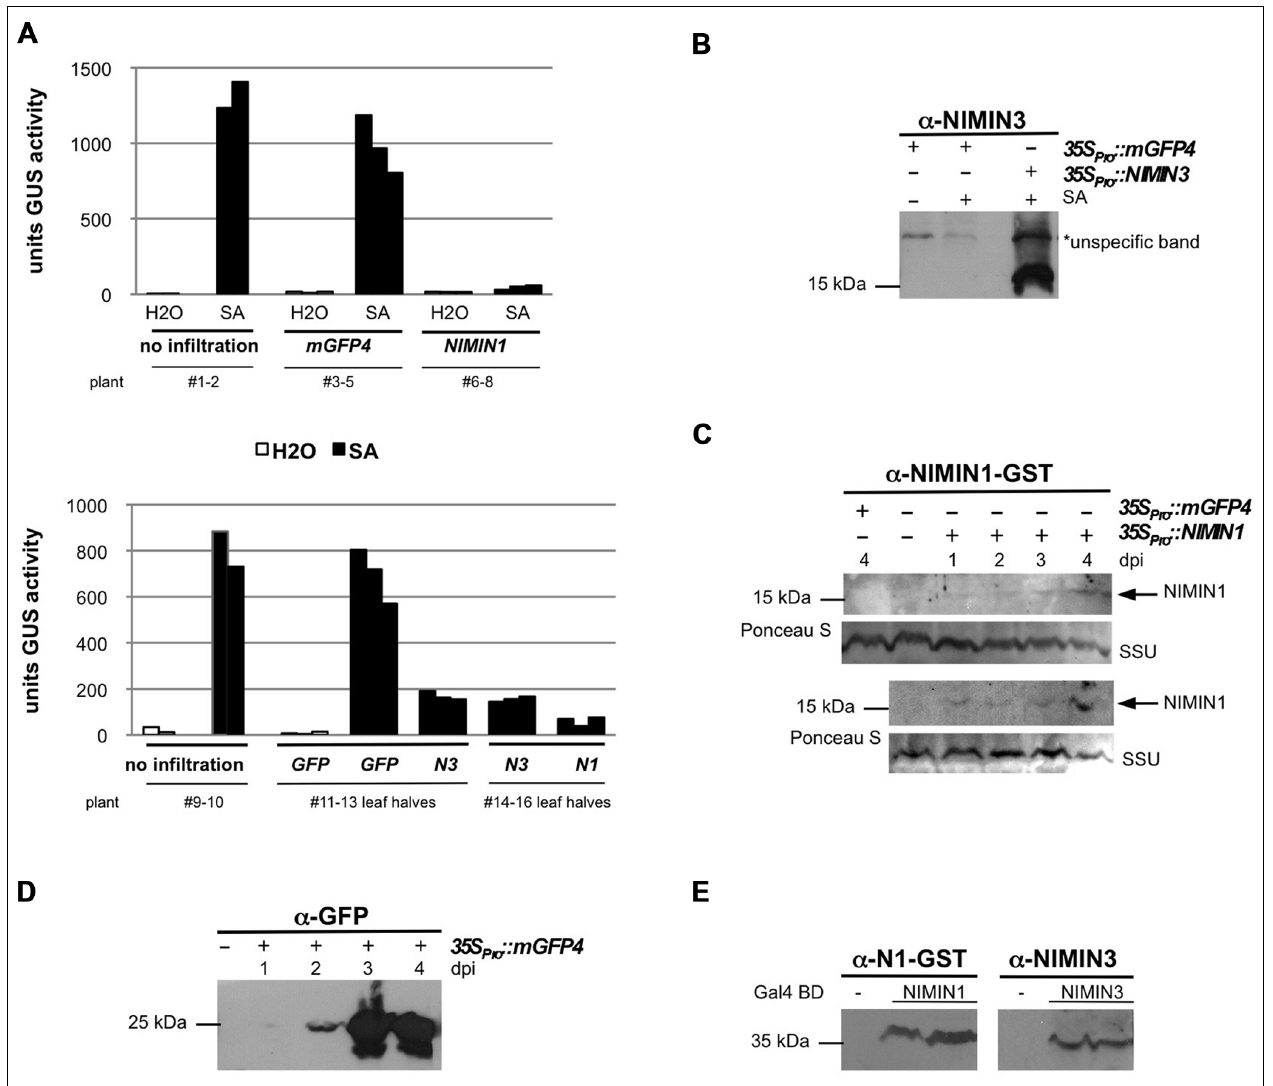
FIGURE 3 | Arabidopsis NIMIN1 and NIMIN3 suppress salicylic acid-induced gene expression from the tobacco PR-1a promoter in N. benthamiana . (A) Effects of transient expression of 35S Pro ::NIMIN1 and 35S Pro ::NIMIN3 in an N. benthamiana reporter line with integrated -1533PR-1a Pro ::GUS .Three plants were infiltrated in parallel for each gene construct with Agrobacterium strains as indicated. For a better direct comparison, the two halves of the same leaf were infiltrated with Agrobacteria harboring 35S Pro ::NIMIN1 and 35S Pro ::NIMIN3 , respectively. Leaf disks excised from infiltrated leaf areas were floated on water or on 1 mM SA before determination of GUS enzyme activity.The three bars for each construct and treatment represent GUS activities from the three agroinfiltration experiments performed in parallel. Representative results are shown. N1, NIMIN1; N3, NIMIN3. (B) Immunodetection of NIMIN3 in extracts from agroinfiltrated and SA-floated leaf tissue. NIMIN3 accumulation